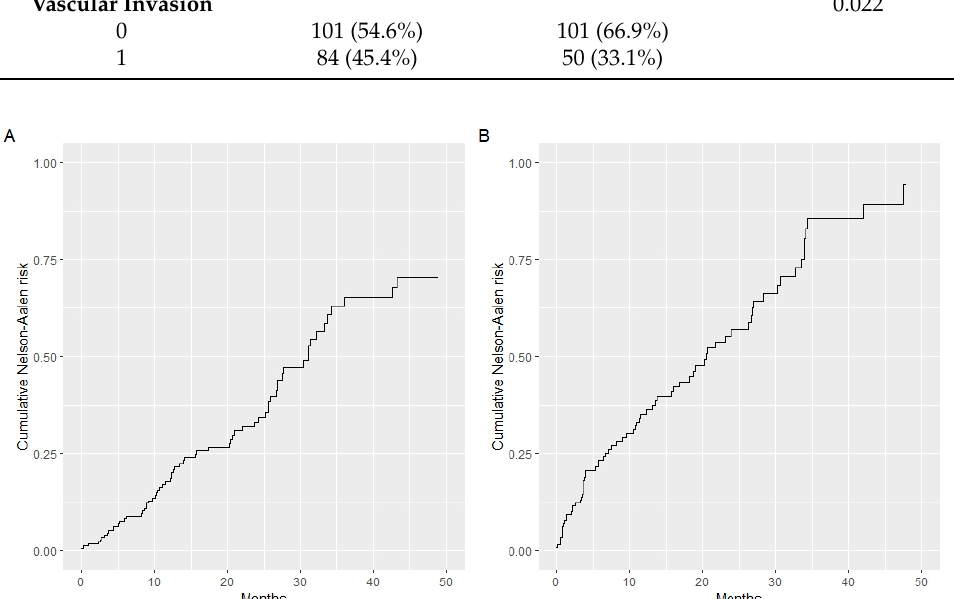
Figure 1. Baseline cumulative hazards of the training and validation cohorts. c-Harrell index values: 0.71 training cohort ( A ); 0.76 validation cohort ( B ).